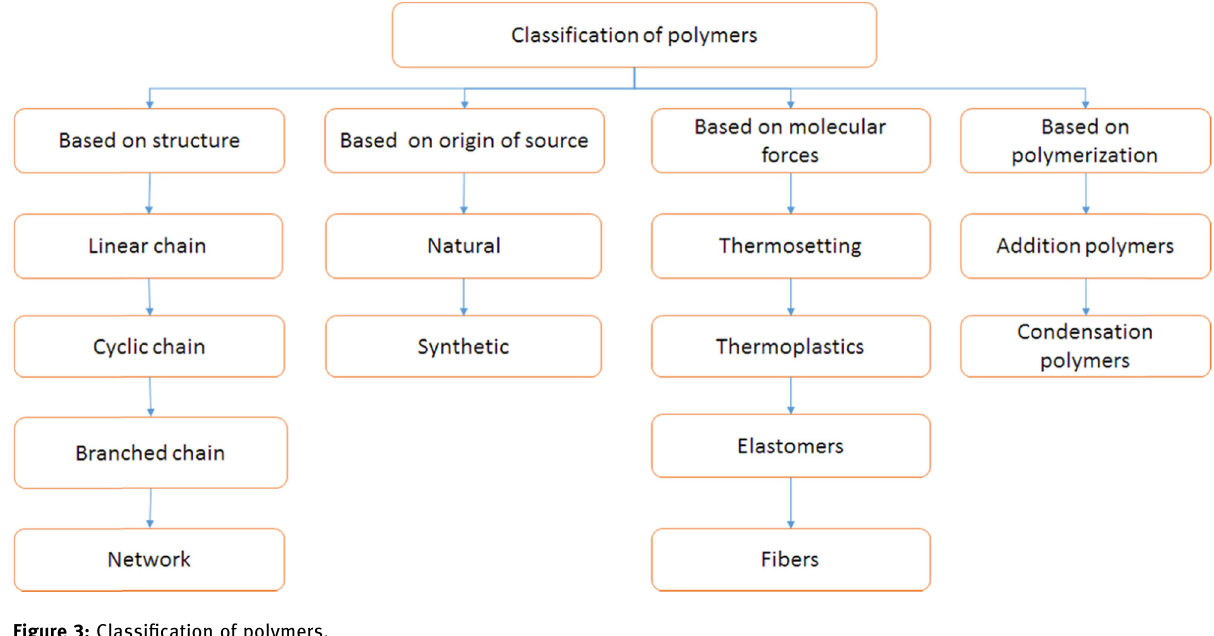
Figure 3: Classi fi cation of